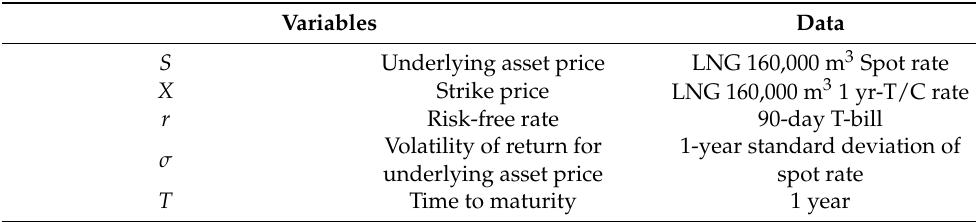
Table 3. Parameters of the